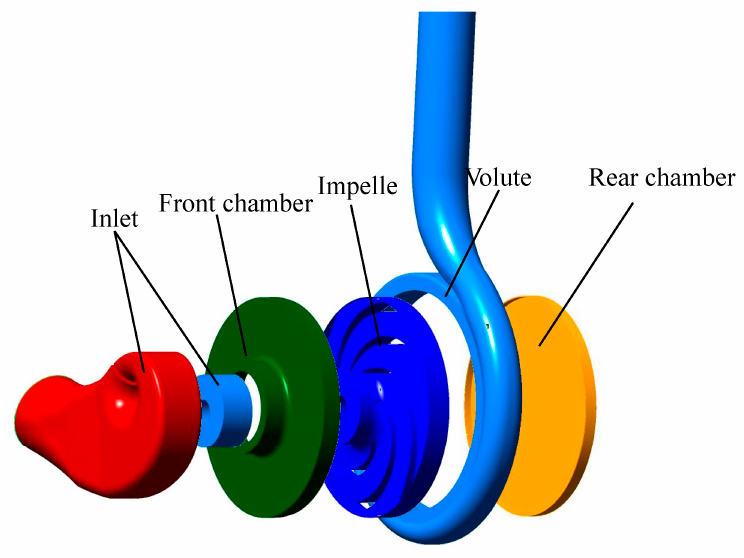
Figure 3. 3D model of the calculation domain.